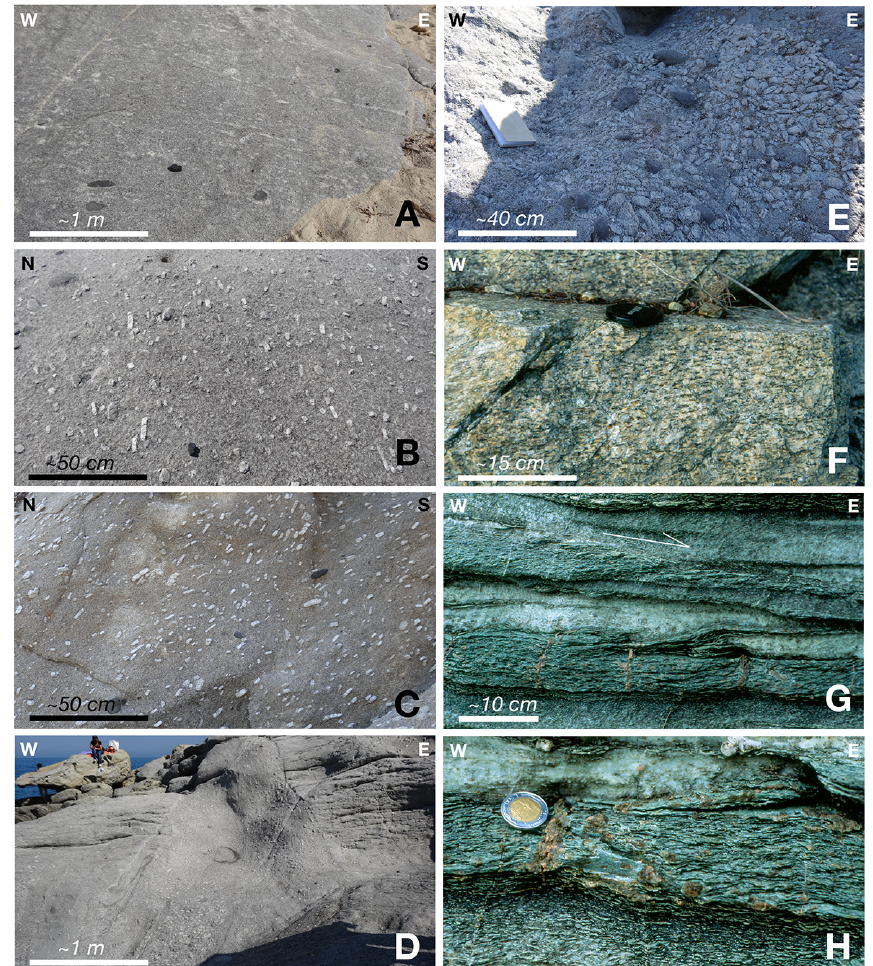
Figure 8. Photographs of the Sant’Andrea facies in the Monte Capanne pluton and of the deformation along the eastern margin of the pluton, in the pluton itself and in the contact metamorphic aureole. (a) General view of the orientation of K-feldspar megacrysts and some mafic enclaves. (b) Detailed view of the oriented K-feldspar megacrysts (horizontal plane). (c) Zoom on the orientation of K-feldspar megacrysts (vertical plane). (d) Cotoncello dyke. (e) Cluster of K-feldspar megacrysts in the vicinity of the Cotoncello dyke. (f) Mylonitic foliation within the Monte Capanne shear zone. (g) Sigmoidal foliation and top-to-the-east sense of shear within the metamorphic aureole of the Monte Capanne pluton. (h) Detailed view of syn-kinematic contact metamorphism garnets in veins perpendicular to the regional stretching